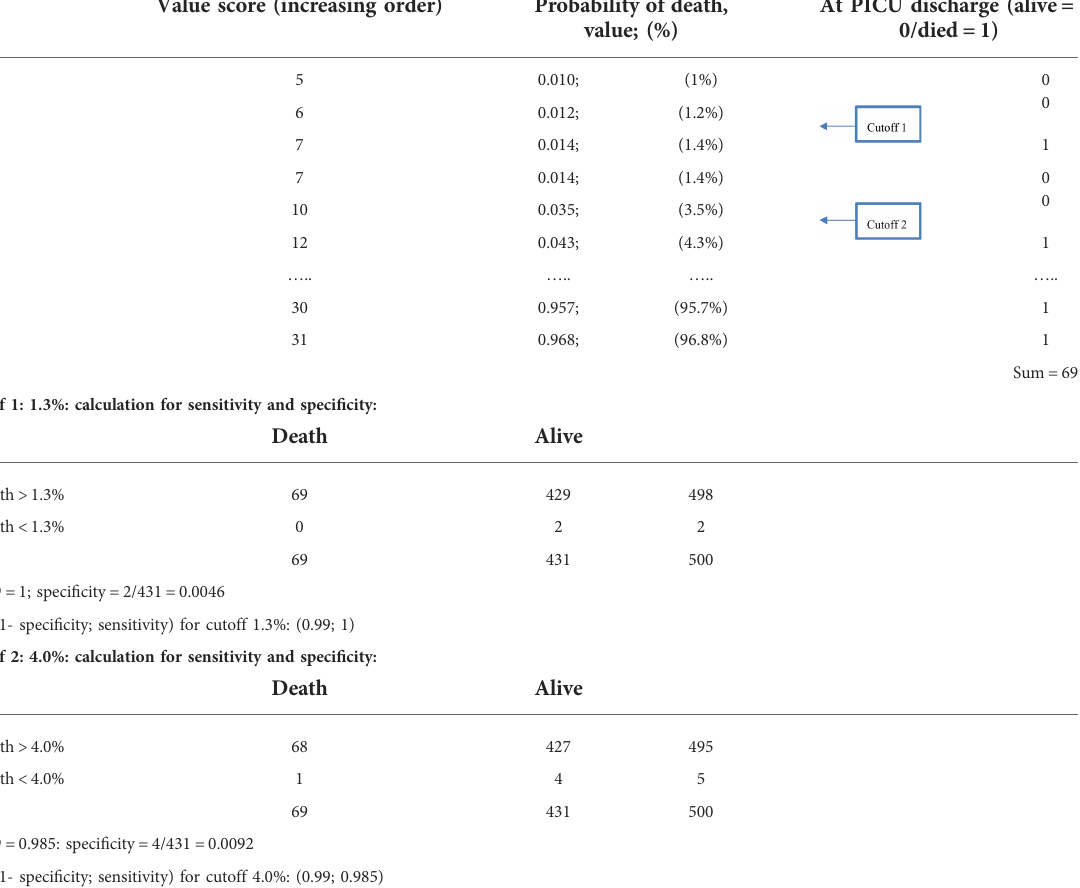
TABLE 1 Example of discrimination for a score on a population (500 patients). Patients